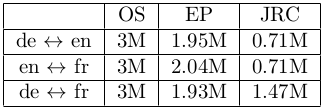
Table from the paper: Monolingual and Cross-lingual Zero-shot Style Transfer
Table text:
OS
EP
JRC
de ↔ en
3M
1.95M
0.71M
en ↔ fr
3M
2.04M
0.71M
de ↔ fr
3M
1.93M
1.47M